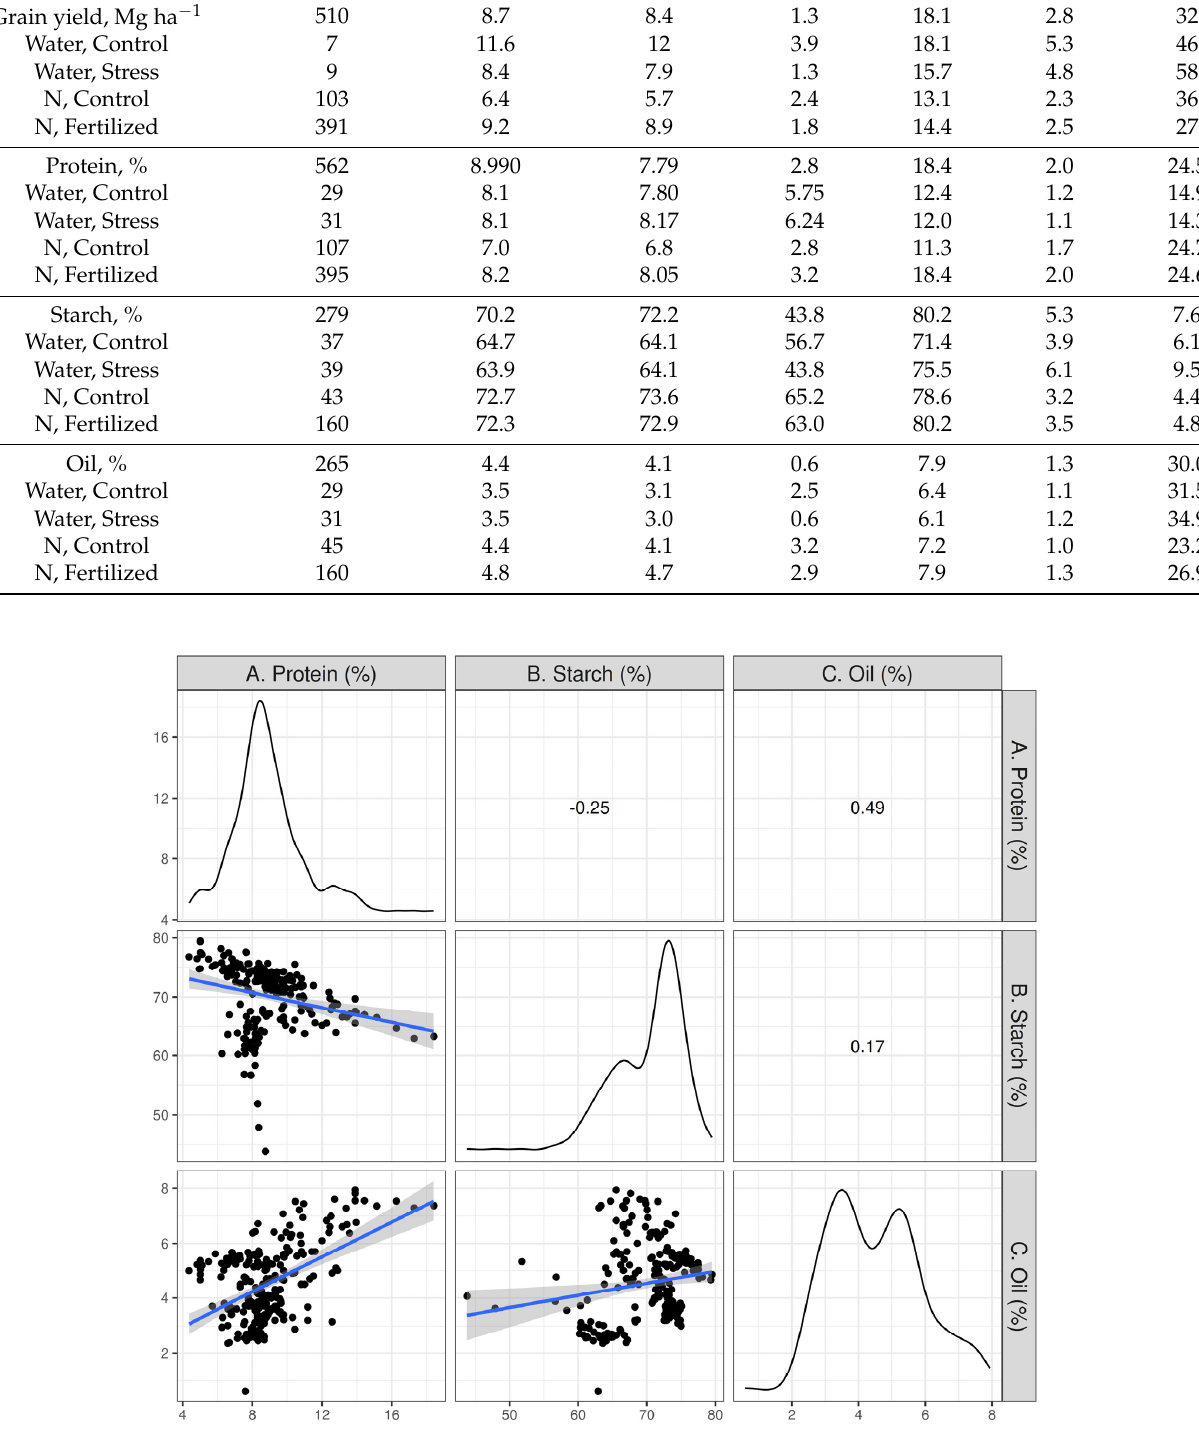
Figure 1. Correlation matrix between protein (( A ), %), starch (( B ), %), and oil (( C ), %), all expressed in concentration (%), considering a subset of studies (11) where the three variables were quantified ( n = 239) (Table 1).